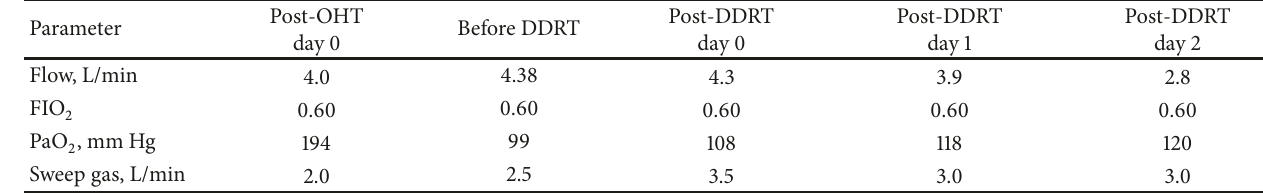
Table 2: Extracorporeal membrane oxygenation parameters before and after